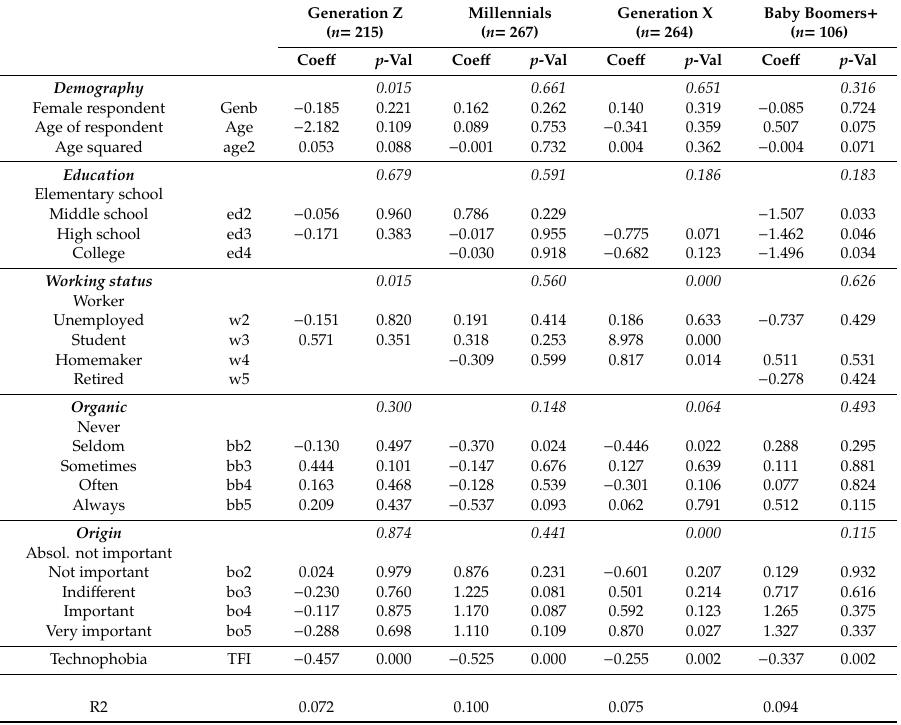
Table 7. Regression of willingness to try food with upcycled ingredients and superior nutrition properties (TNUT) by generations.